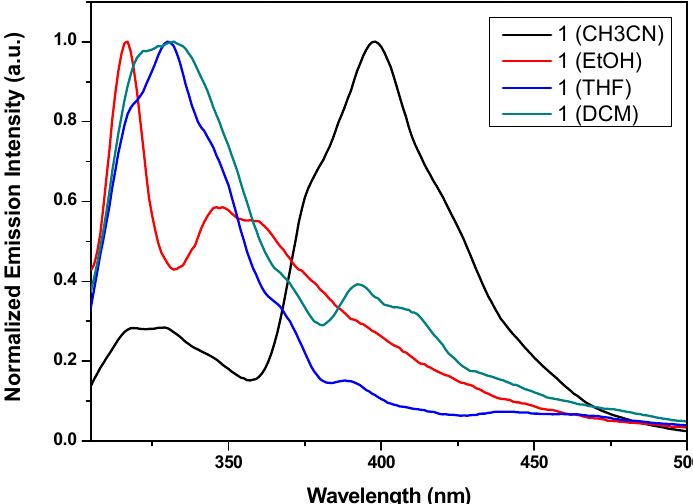
Figure 7. Normalized emission spectra of 1 were excited at 286 nm in CH 3 CN (black), EtOH (red), THF (blue), and DCM (greenish blue) at room temperature in air.